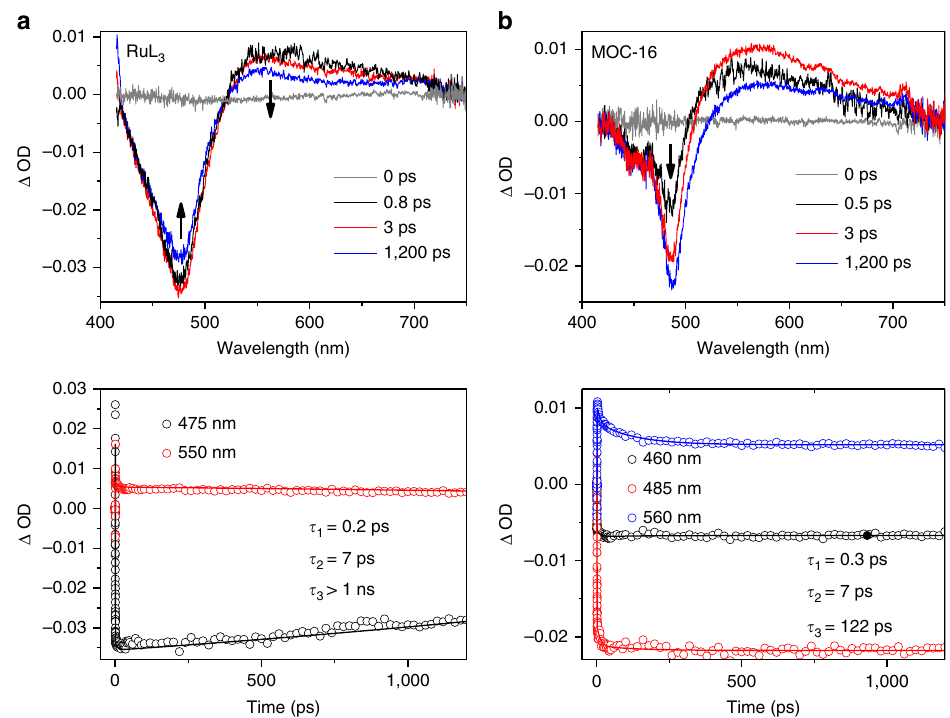
Figure 5 | Transient absorption (TA) spectra excited at 400 nm and corresponding kinetic traces at selected wavelengths. ( a ) RuL 3 and ( b ) MOC-16 in